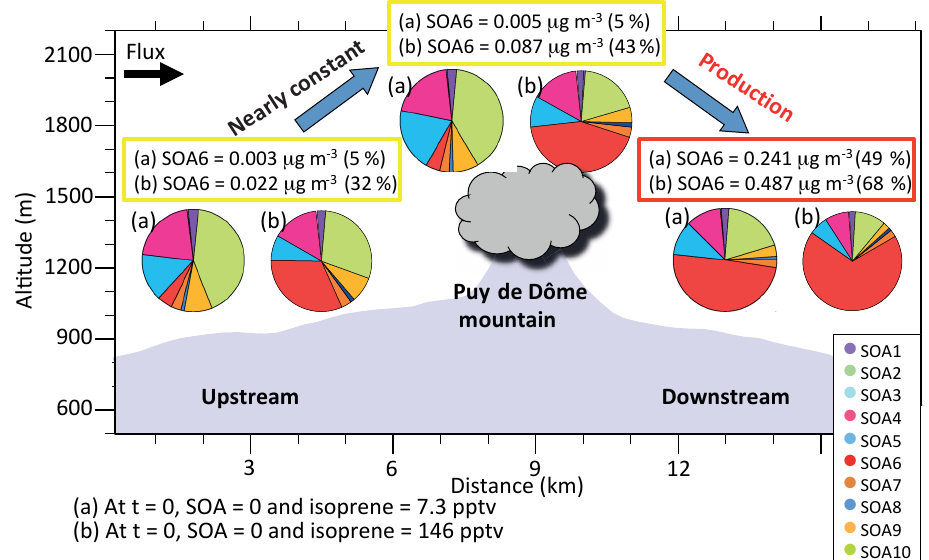
Figure 14. Mass concentration of the class 6 secondary organic aerosol (SOA6) upstream, at the summit, and downstream of the Puy de Dôme mountain (rectangular box). The contribution of the 10 classes of secondary organic aerosols to the total mass is represented by a pie chart for (a) an isoprene initial mixing ratio of 7.3pptv and (b) an isoprene initial mixing ratio of 146pptv (multiplied by 20).